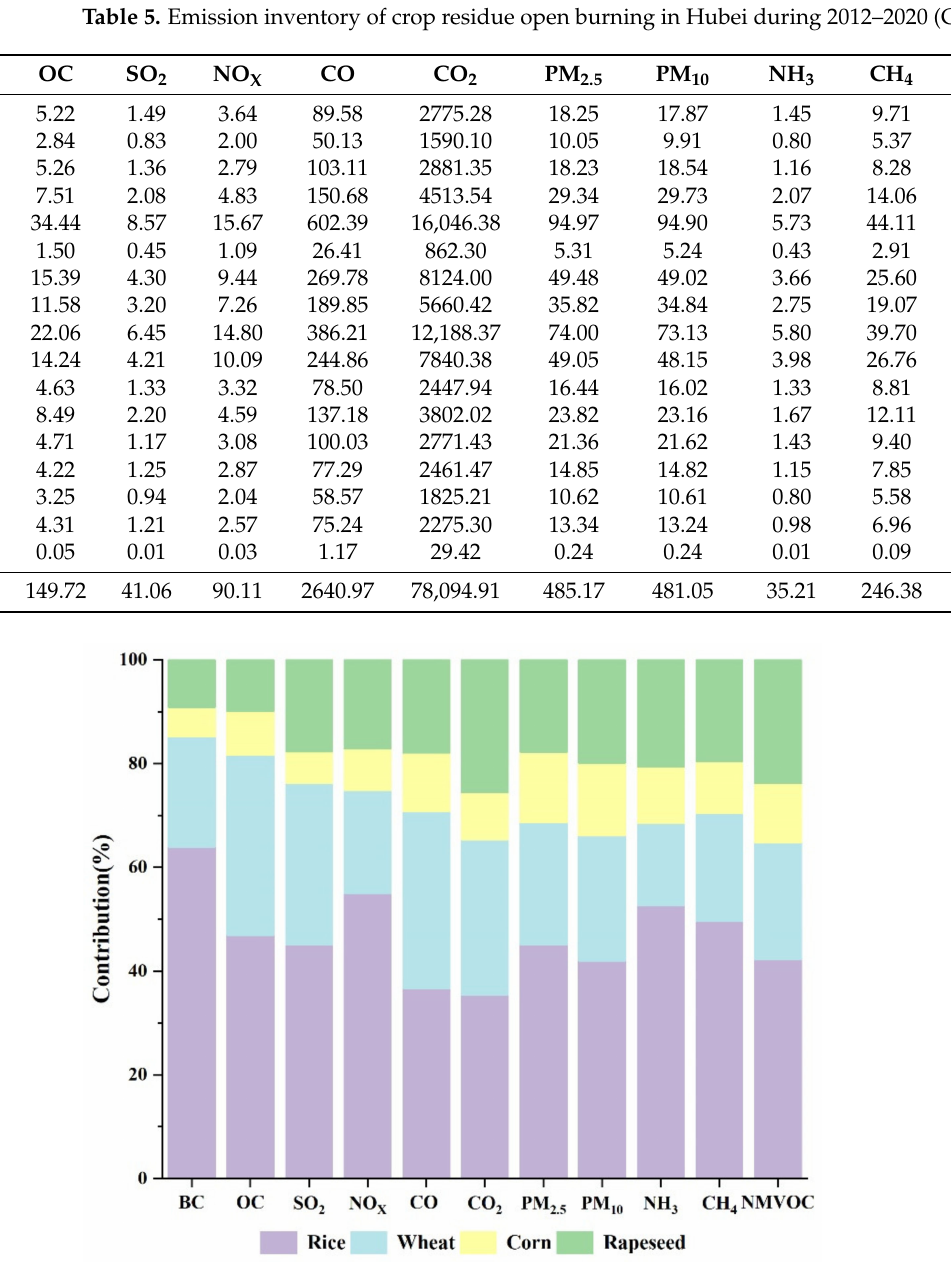
Figure 2. Emission contributions by different crop residues in Hubei from 2012 to